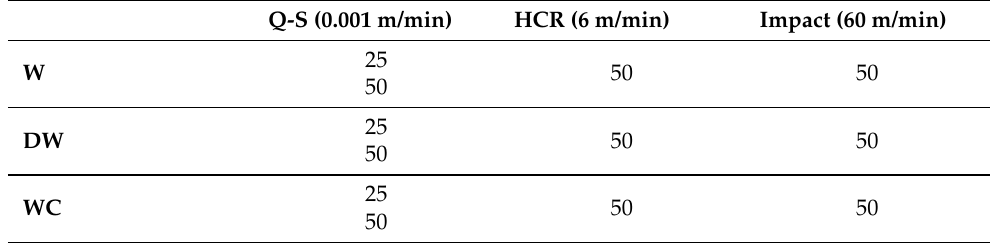
Table 3. Tested joint configurations, highlighting the overlap length (in mm) tested for each